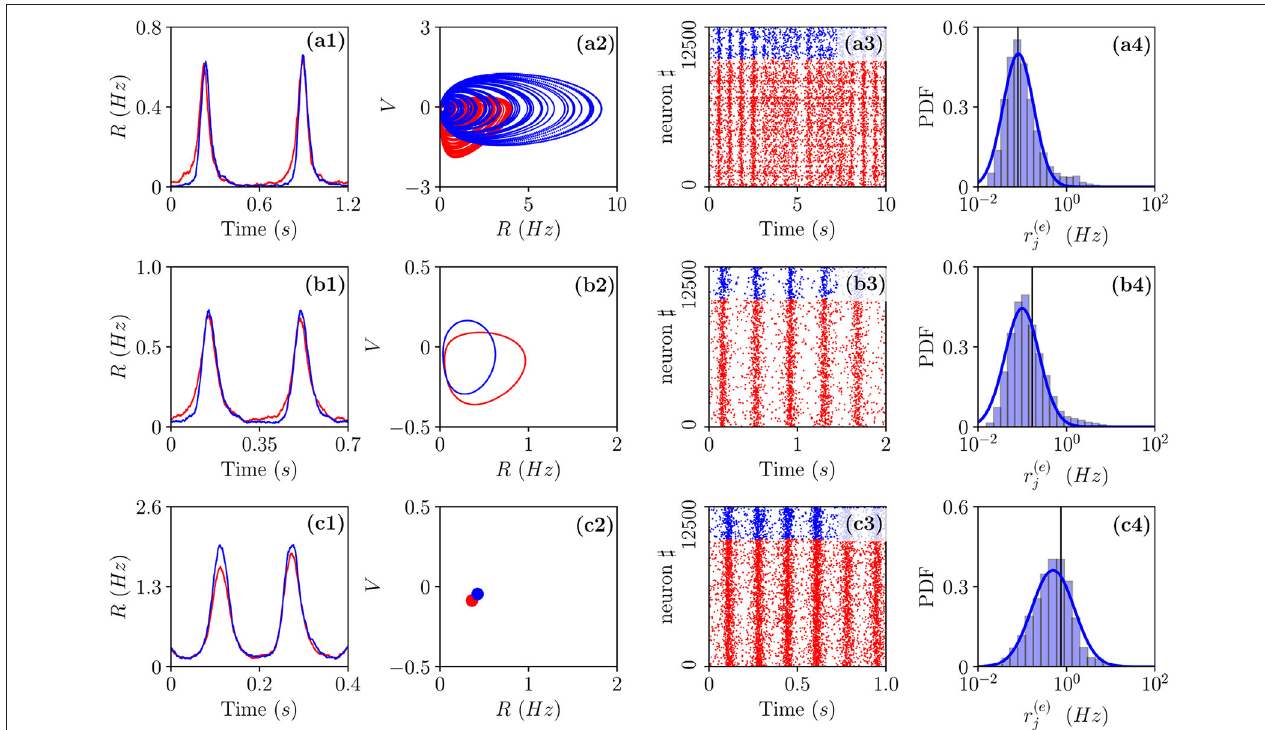
0.00021 in the MF denoted by a red circle in FIGURE 5 | Different types of collective oscillations(COs). Row (a) refers to the chaotic state observable for I ( e ) 0 = Figure 4a ; row (b) to the oscillatory state of the MF observable for I ( e ) 0 0.0009 denoted by a blue square in Figure 4a ; row (c) to the stable focus for the MF = observable for I ( e ) 0 0.006 denoted by a green triangle in Figure 4a . The first column displays the population firing rates vs. time obtained from the network dynamics, = the second, the corresponding MF attractors in the planes identified by ( R ( e ) , V ( e ) ) and ( R ( i ) , V ( i ) ), the third, the raster plots, and the fourth, the PDFs of the excitatory firing rates r ( e ) j . Red (blue) color refers to excitatory (inhibitory) populations, the solid vertical lines in column 4 to the mean firing rate and the blue solid line to a fit to a 2.0, K =1,000. For the estimation of the firing rates we employed N ( e ) =40,000 and 0.3, 1 ( ee ) 0 log-normal distribution. Parameters as in Figure 2 , apart from 1 ( ii ) 0 = = N ( i ) =10,000, while for the raster plots, N ( e ) =10,000 and N ( i ) =2,500. The total integration time has been of 120 s after discarding a transient of 80